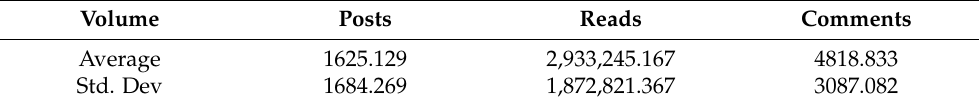
Table 5. Summary statistics of the Guba sample. Table 5 presents the summary statistics of the Guba sample, including mean ( Average ) and standard deviation . Posts , Reads, and Comments are the average number of overnight posts, reads, and comments corresponding to a trading day,